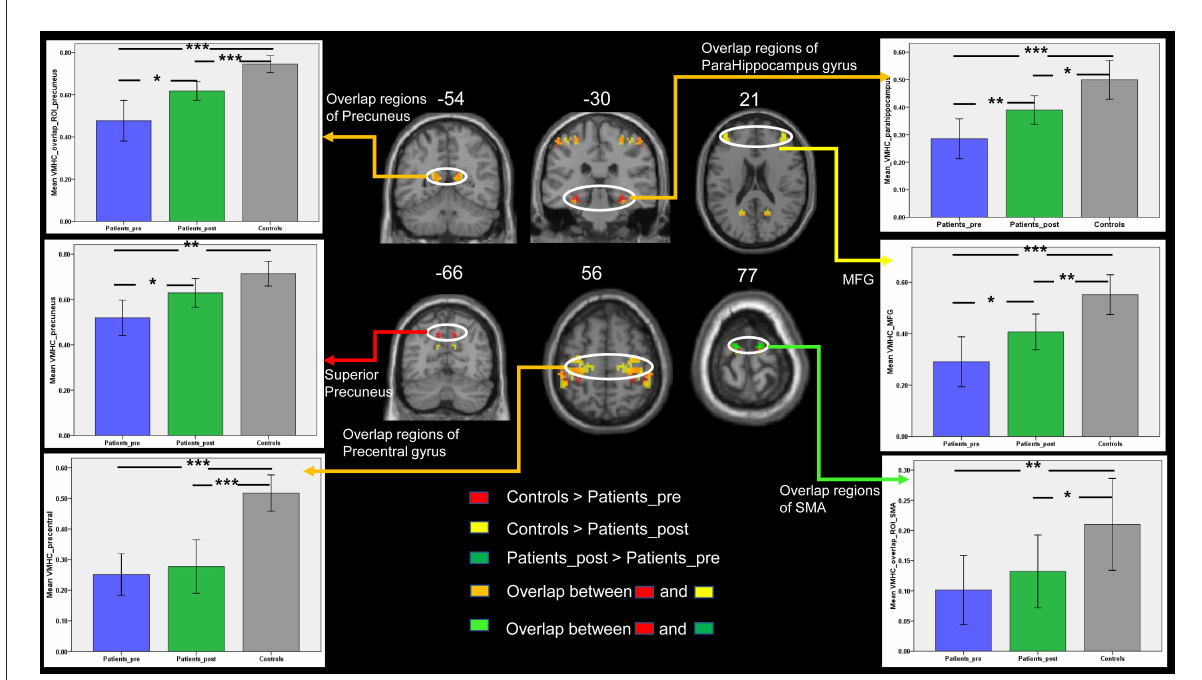
FIGURE3 The comparisons of VMHC between the three groups in the DMN and motor-related regions of interest. Bars represent the mean and error bars represent the standard deviations. SMA, supplementary motor area; MFG, middle frontal gyrus. Patients_pre = the patient group in the pretreatment stage. Patients_post = the patient group in the posttreatment stage. *, p < 0.05; **, p < 0.01; ***, p <